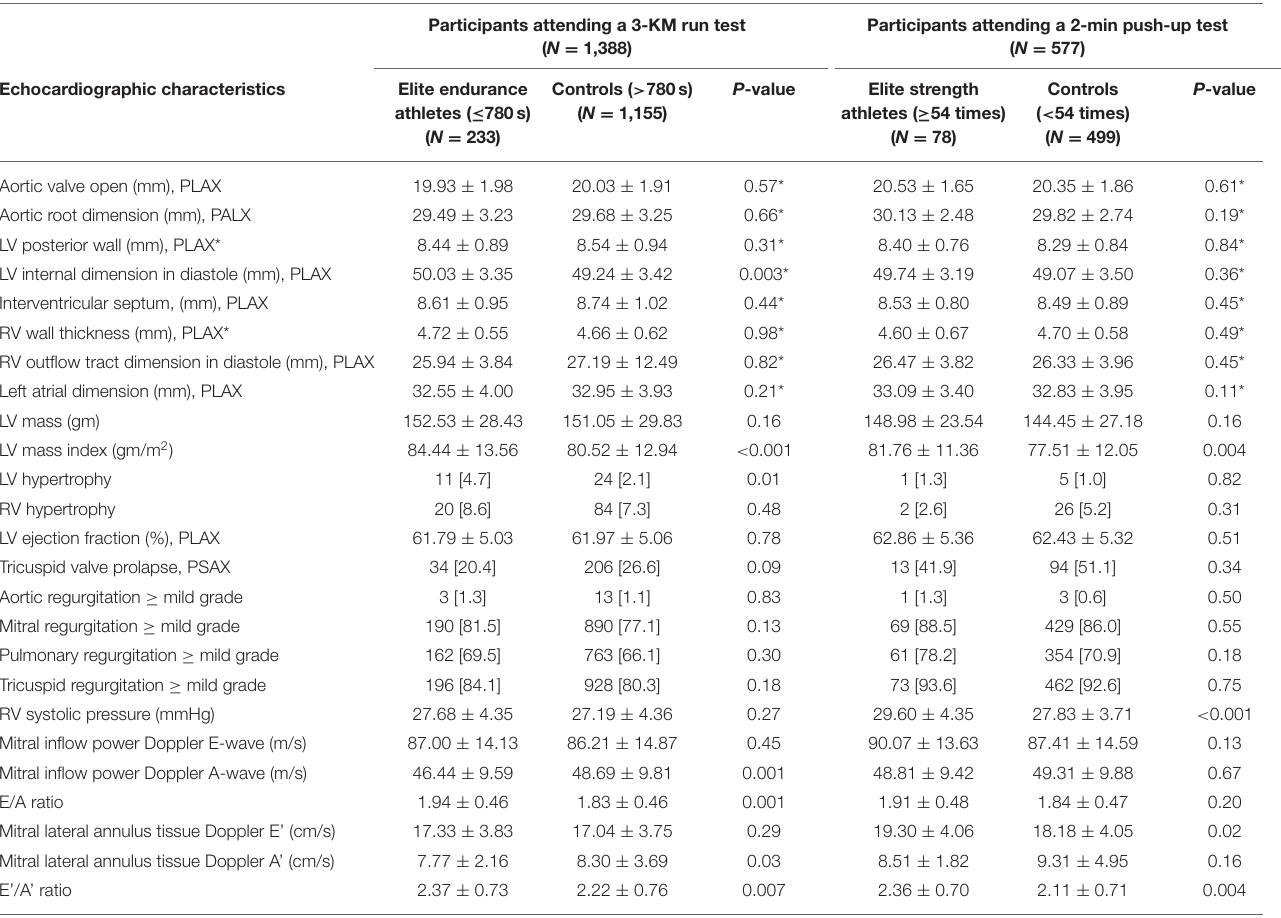
TABLE 3 | Echocardiographic characteristics of elite endurance and strength athletes and non-elite